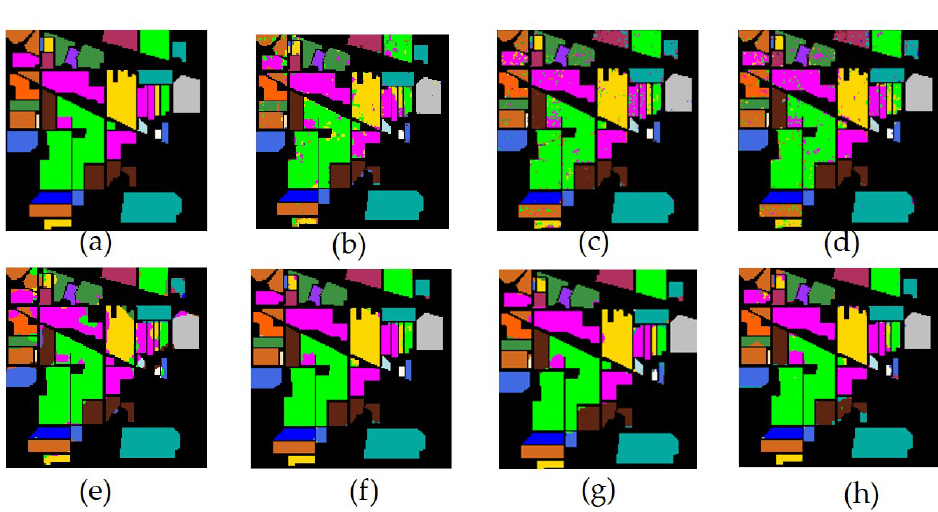
Figure 7. Classification maps for Indian Pines dataset. ( a ) Ground-truth map; ( b ) SVM-3DG; ( c ) 1D-